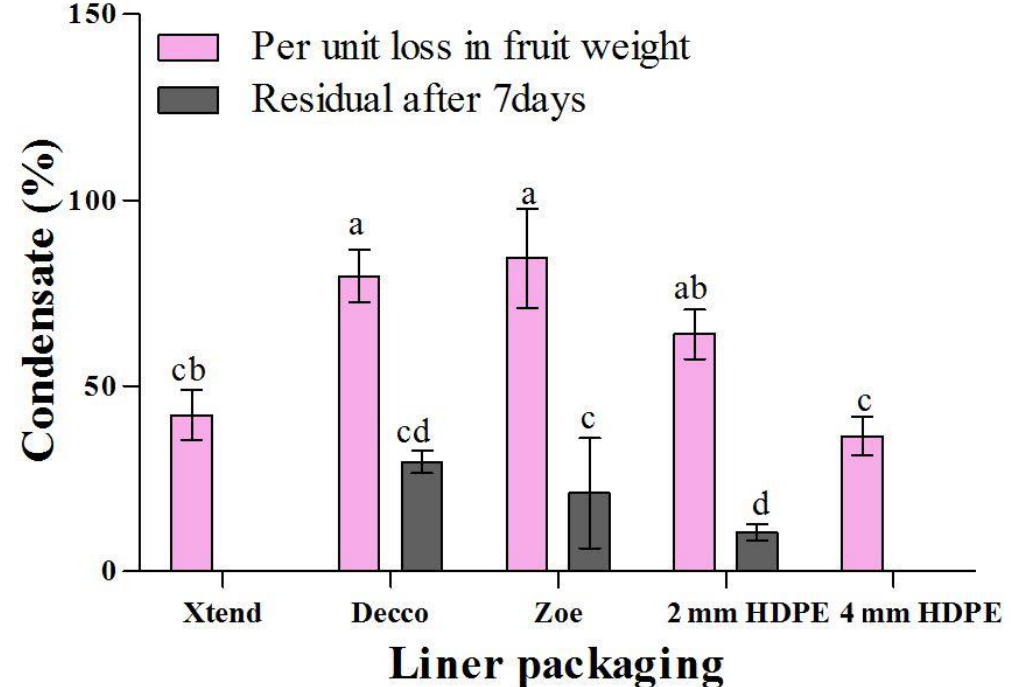
Figure 6. Condensate within liner bags with respect to weight lost for pomegranate (cv. Wonderful) stored at 5 °C and 90% RH for 1 d and condensate retained within plastic bags after a period of 7 d at 5 °C and 90% relative humidity (RH). Histograms columns with different letters are significantly different at p < 0.05 according to Duncan’s multiple range test. Vertical bars represent S.E. HDPE: high density polyethylene.